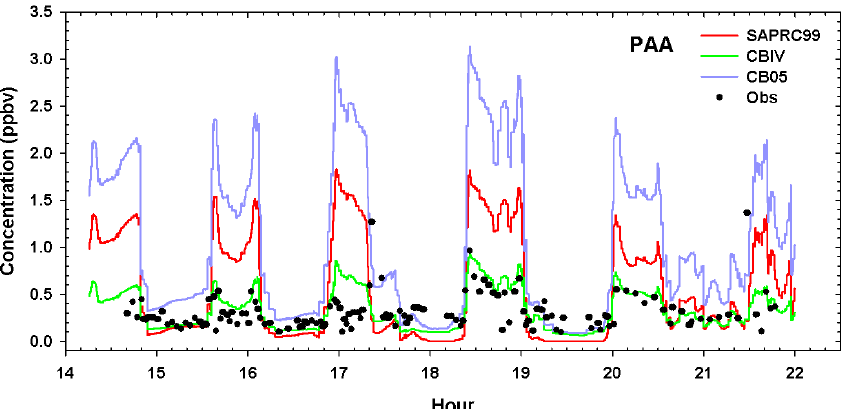
Fig. 5. Comparison of modeled and observed PAA concentrations for CBIV, SAPRC99, and CB05 along the path of the flight of the DC8 on 20 July